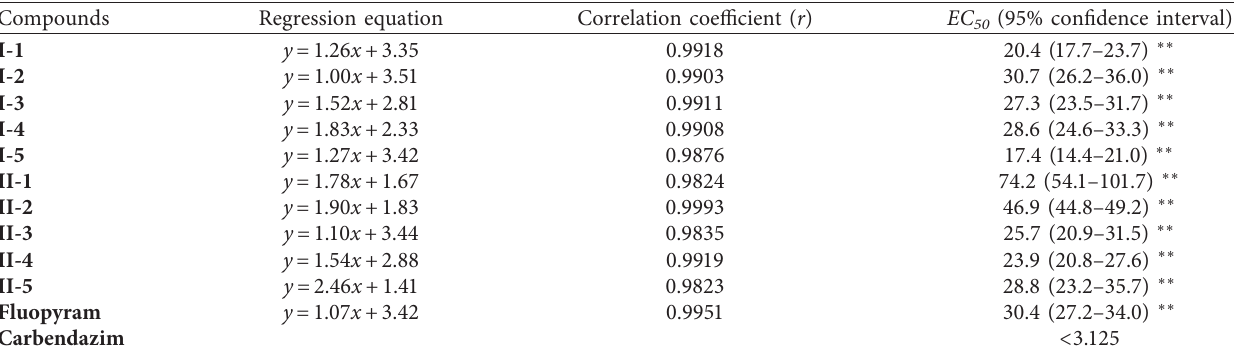
· mL − 1 ) values of the target compounds against Physalospora piricola . 50 , μ g